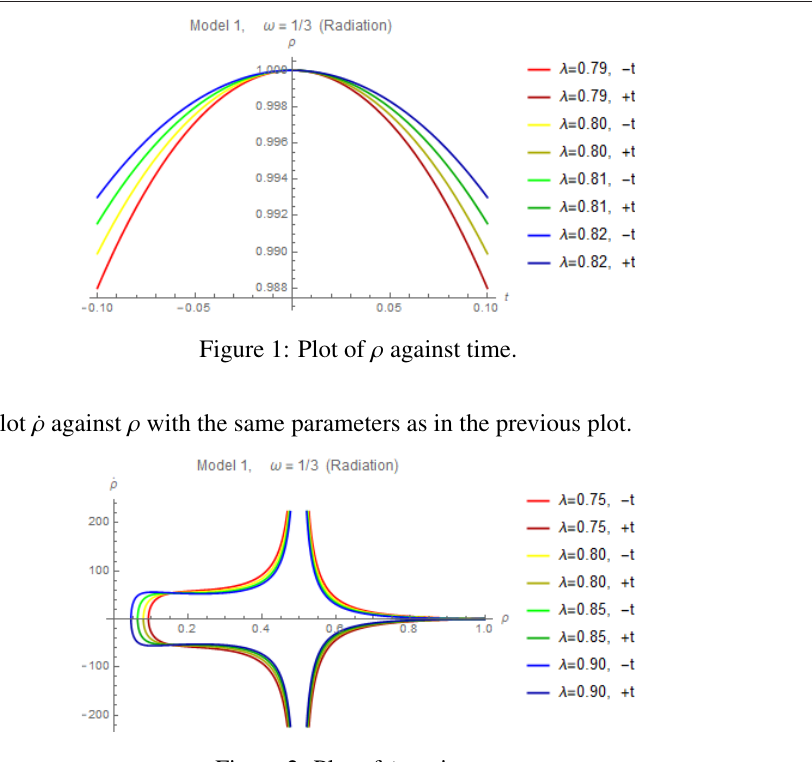
Figure 2: Plot of ˙ ρ against ρ